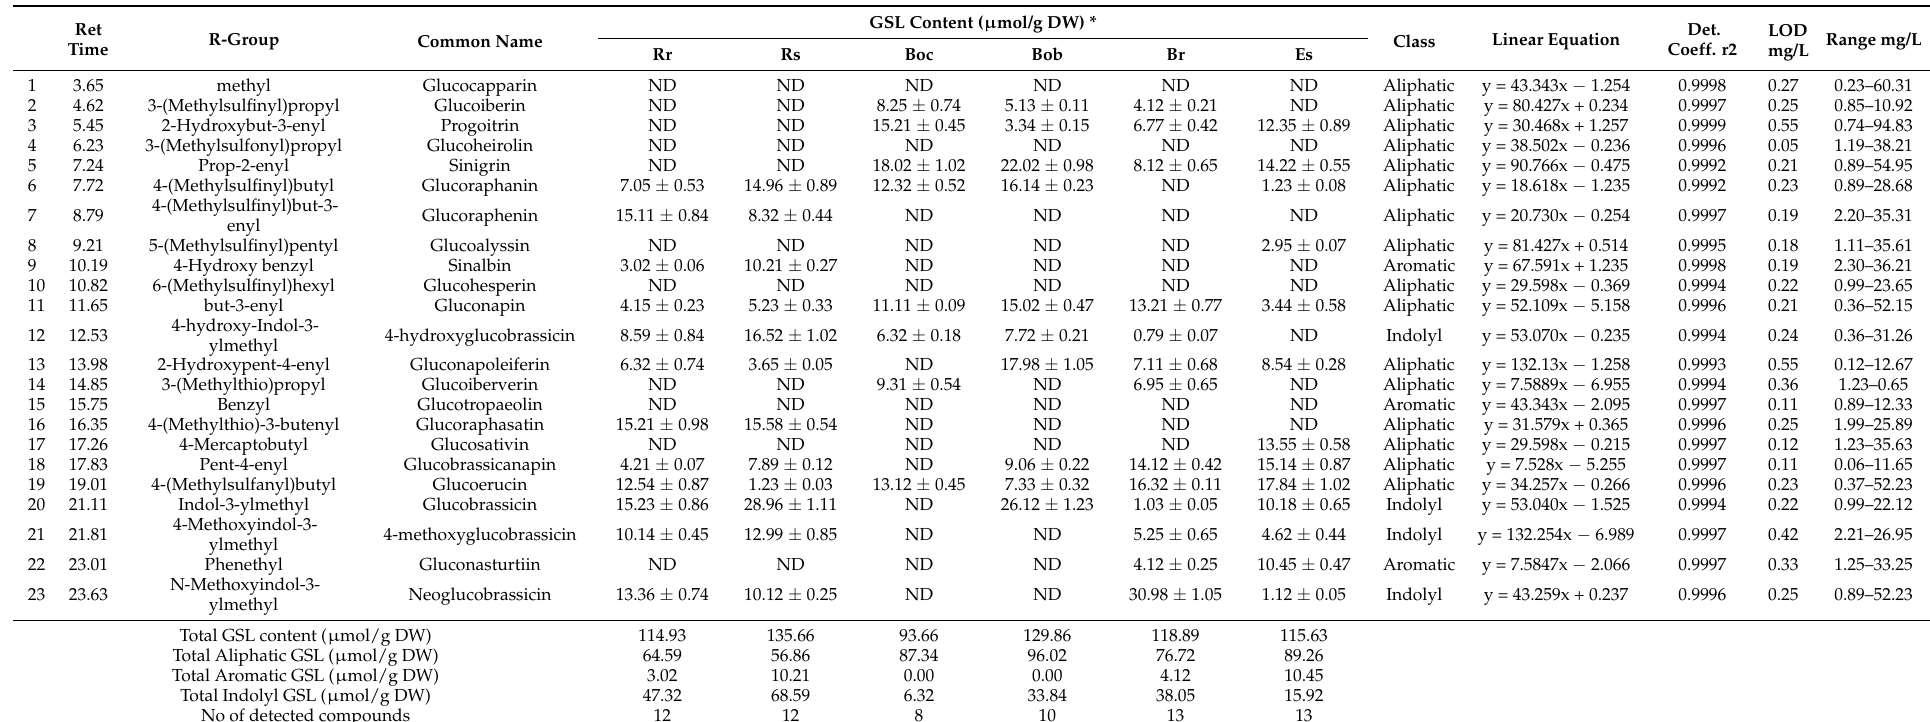
Table 1. Glucosinolate profile in the studied Brassicaceae